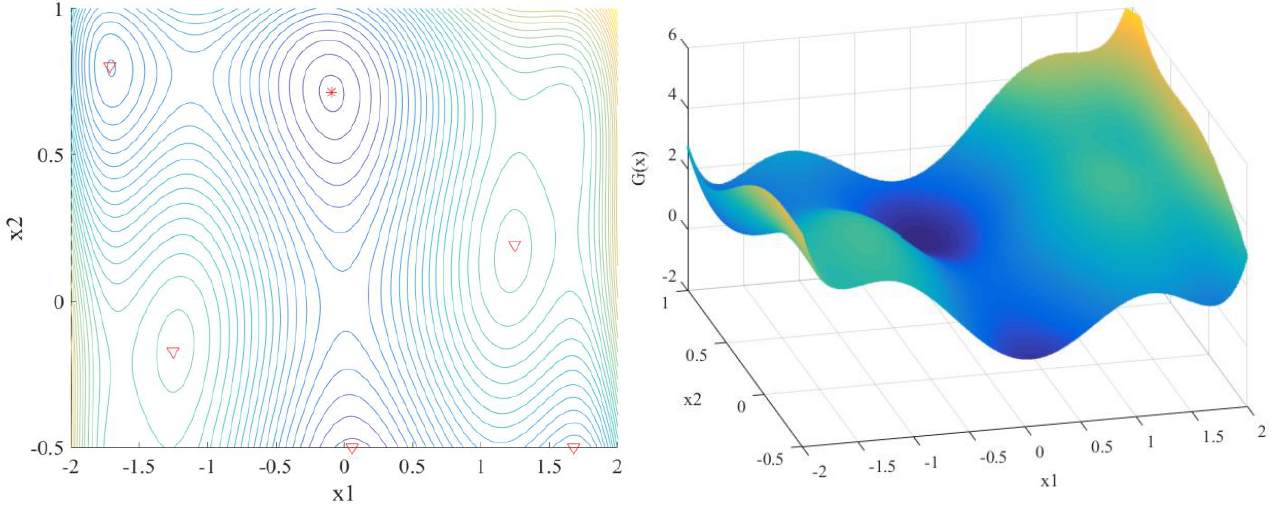
Figure 5. Contour map and 3D map of SC function.